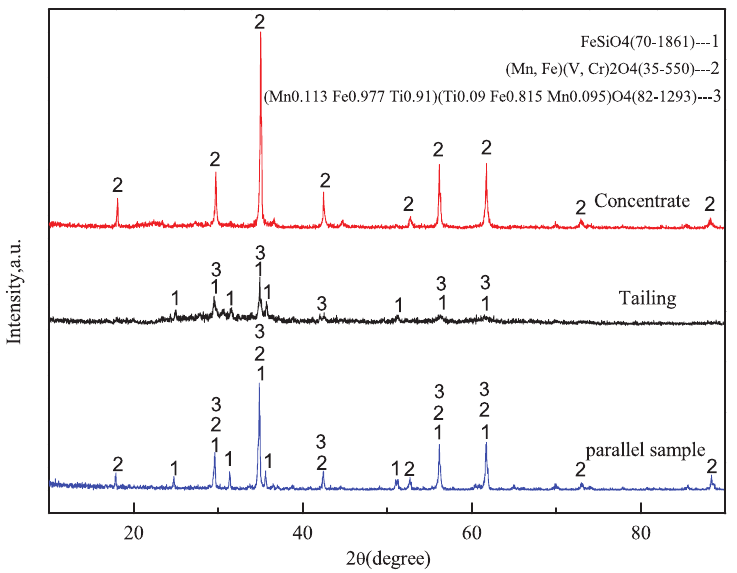
Fig. 9: X-ray diffraction of the samples obtained by centrifugal concentration and the parallel